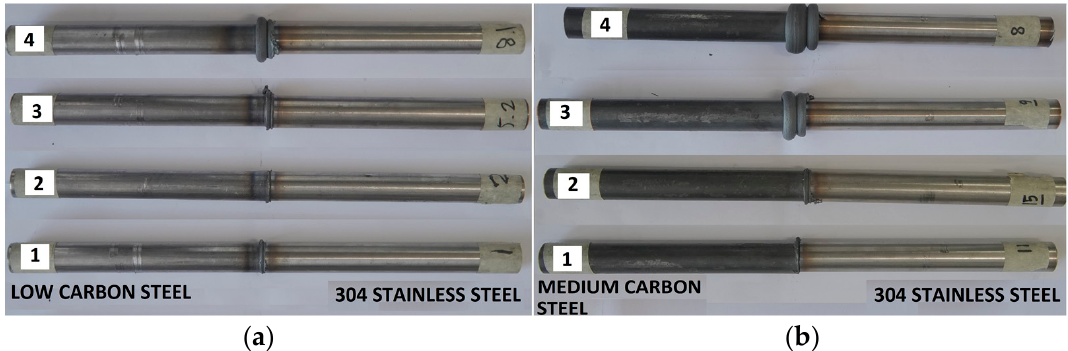
Figure 3. Samples of welded specimens of ( a ) low-carbon steel–304 SS: 1. P f = 16, T f = 4, and P u = 40; 2. P f = 16, T f = 4, and P u = 70; 3. P f = 35, T f = 4, and P u = 40; and 4. P f = 35, T f = 9, and P u = 70 and ( b ) medium-carbon steel–304 SS: 1. P f = 10, T f = 7, and P u = 95; 2. P f = 10, T f = 11, and P u = 95; 3. P f = 90, T f = 7, and P u = 95; and 4. P f = 90, T f = 11, and P u = 120 (units: P = bar, T = second).